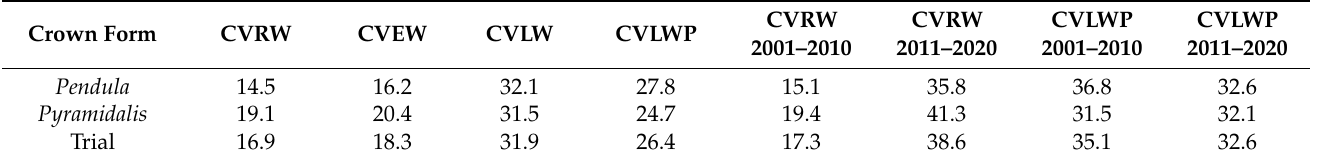
Table 3. The coefficient of variation for ring width (CVRW), earlywood (CVEW), latewood (CVLW), and latewood proportion (CVLWP) for the two crown forms of Norway spruce. Crown Form Pendula